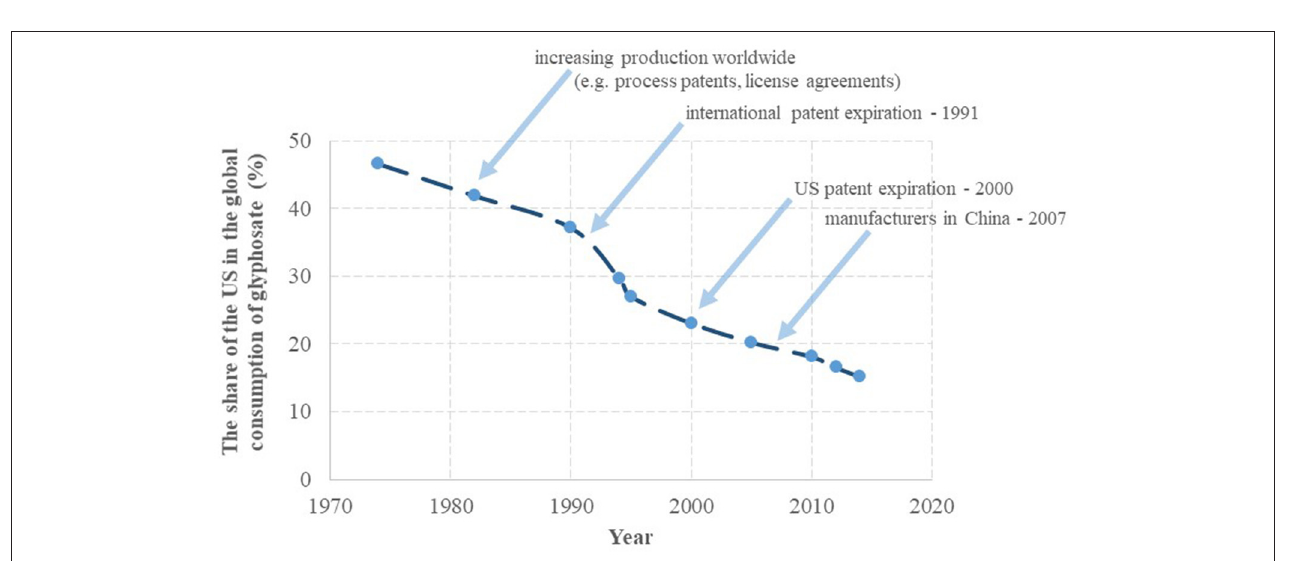
FIGURE 2 | The share of glyphosate uses in the United States from the global annual turnover. On the basis of Benbrook